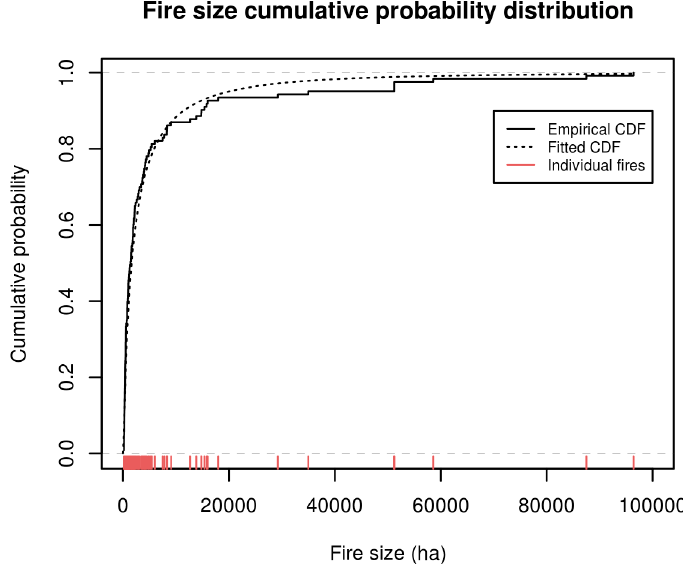
Figure 3. Empirical and fitted cumulative fire size probability distribution ( n = 123).